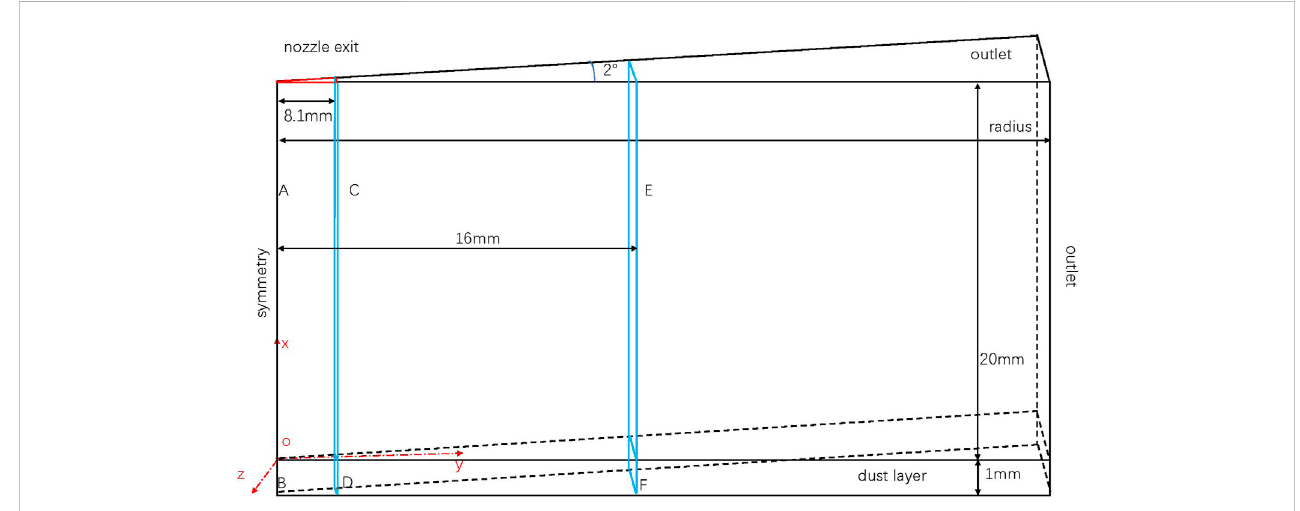
FIGURE 5 Computational domain for the plume-surface interaction study.